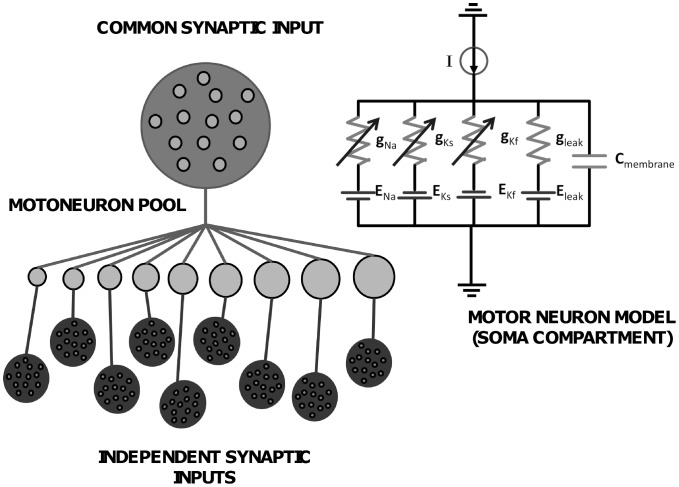
Schematic representation of the model.
A, types of synaptic inputs incorporated in the model. B, equivalent circuit of the motoneuron model (soma compartment).